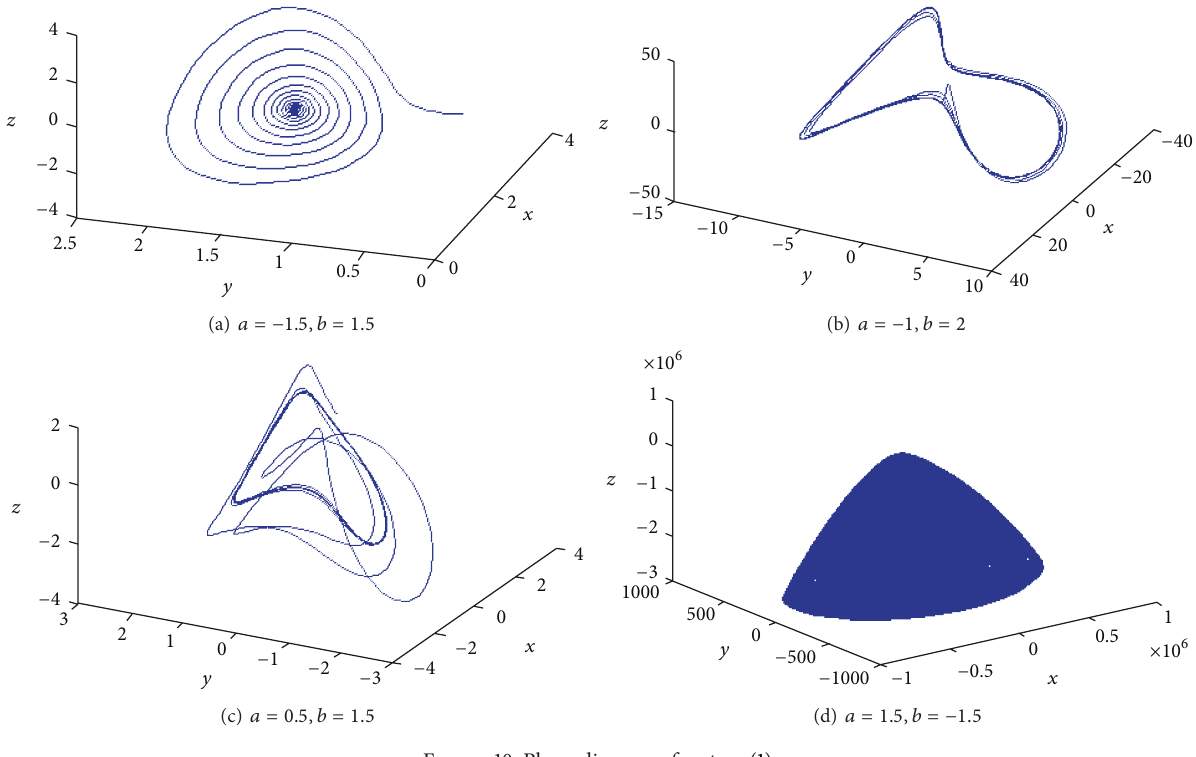
Figure 10: Phase diagram of system